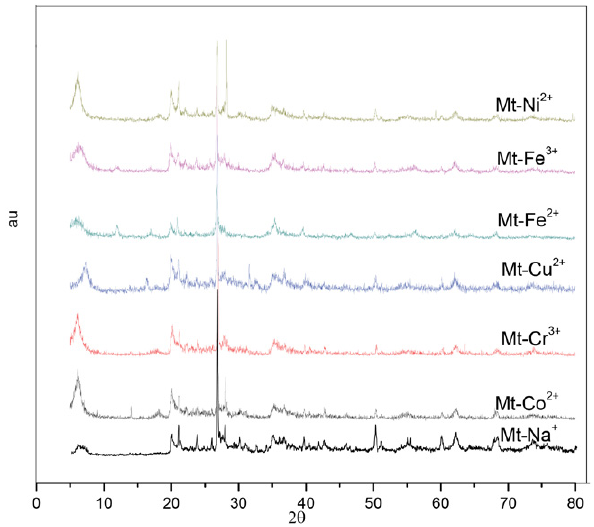
Figure 1. XRD diffractograms of montmorillonite exchanged with different Table1. Basal spacing d 001 and 2θ angle for each cation.